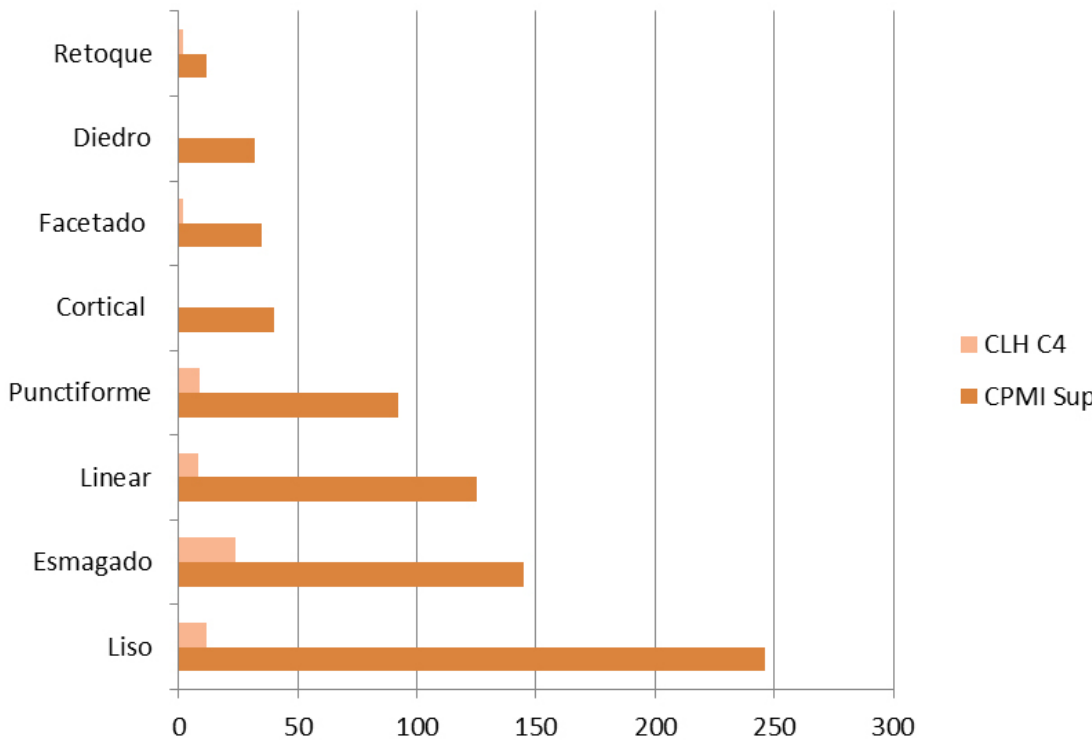
Figura 4. Magdalenense superior : tipos de talão identificados nos conjuntos líticos do nível superior do Cabeço de Porto Marinho I e na camada 3 da Lapa dos Coelhos. Figure 4. Upper Magdalenian: butt types identified in the lithic assemblage of the upper level of Cabeço de Porto Marinho I and Lapa dos Coelhos Layer